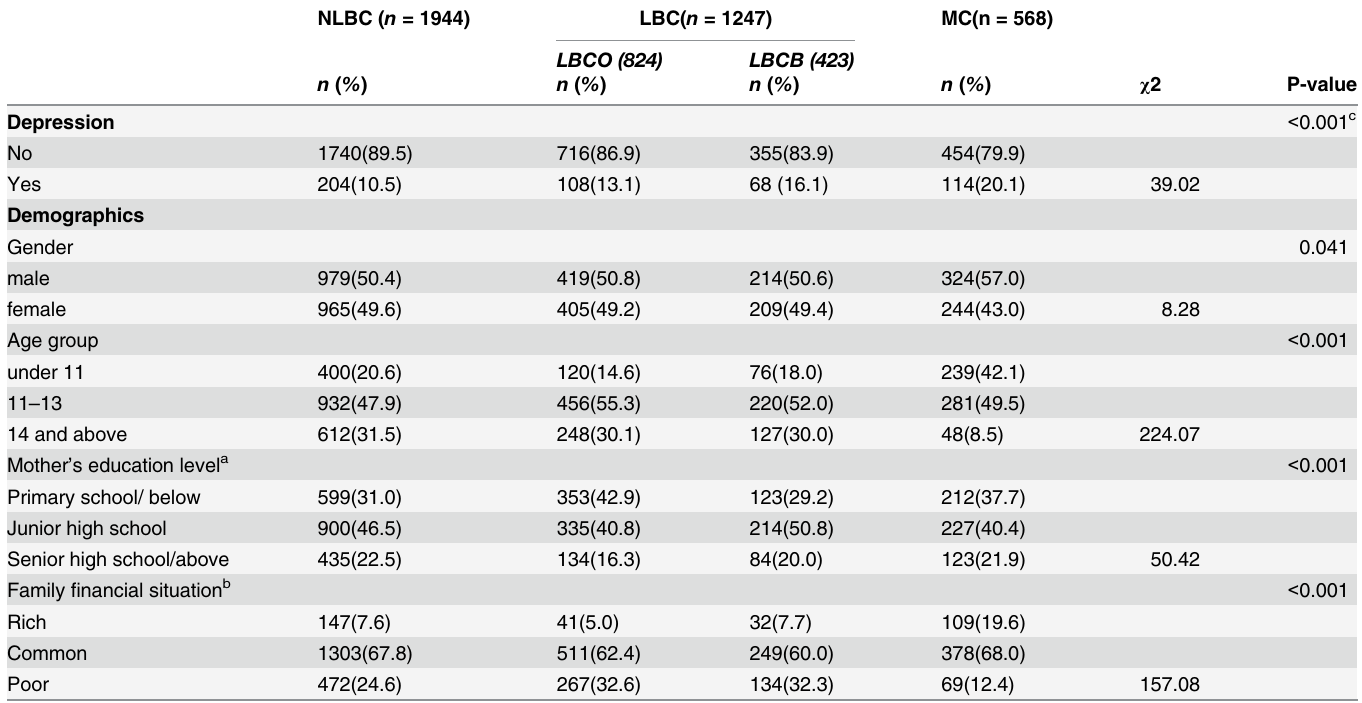
Table 1. Depression rates and demographic characteristics of NLBCs, LBC and MC(N =